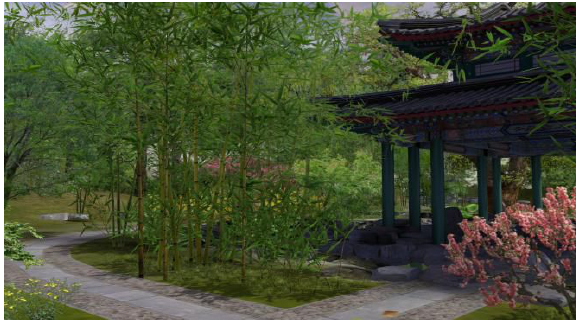
Figure 8. Bamboo in Three-dimensional